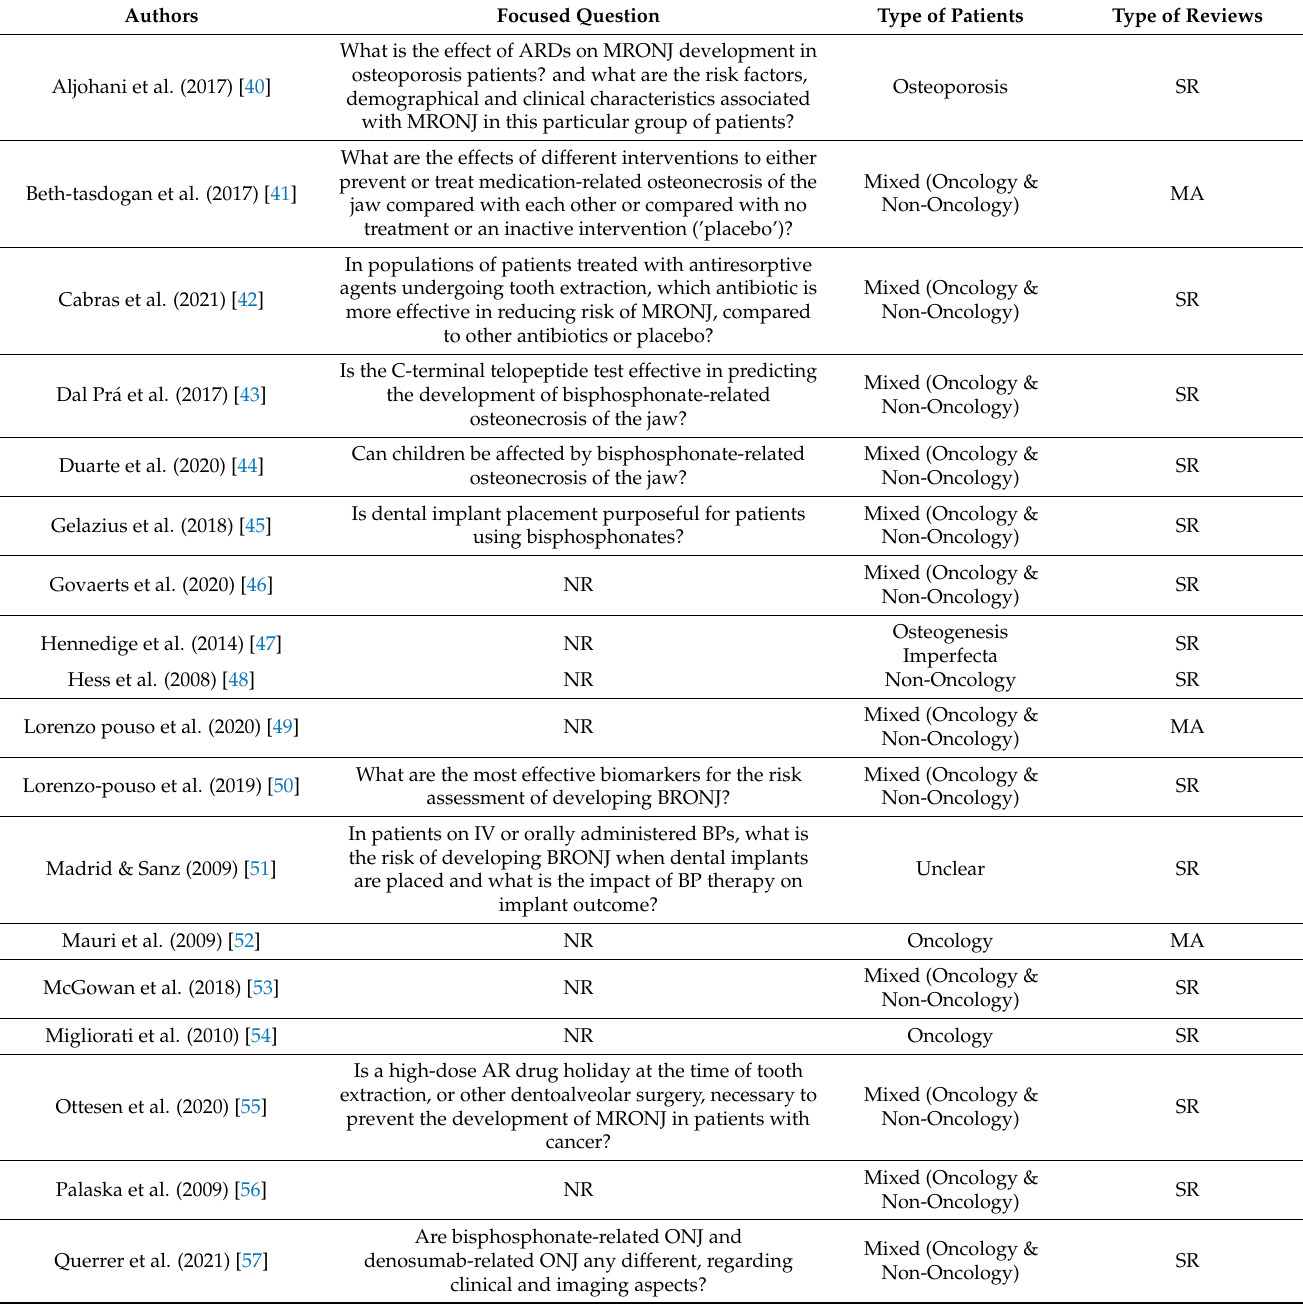
Table 2. Systematic reviews included within this analysis. Systematic review (SR); meta-analysis